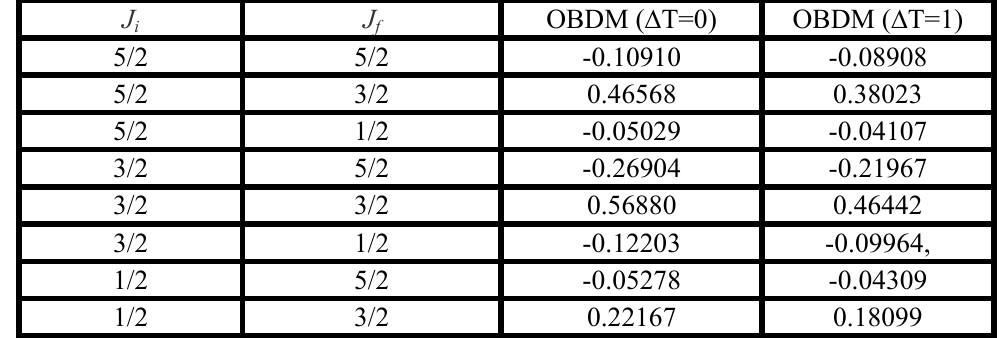
Table 3: The values of the OBDM elements for the longitudinal C2 transition of the 2 1, second 2 state of 58 Ni using F5PVH model space effective interaction for M3Y and Gogny at E =2.743 X